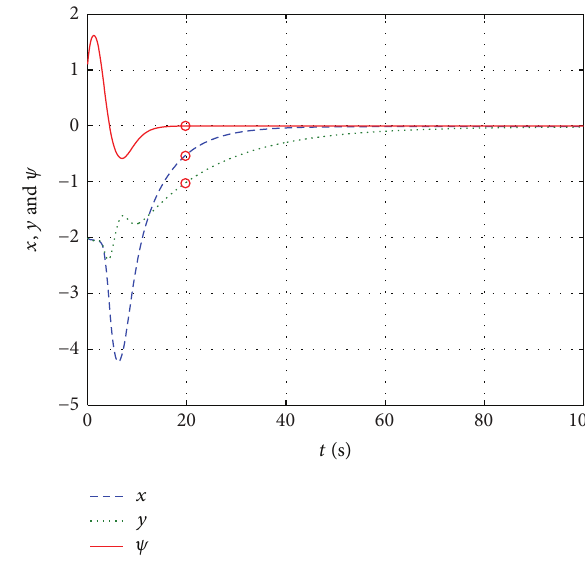
Figure 2: Response of 𝑥 , 𝑦 , and 𝜓